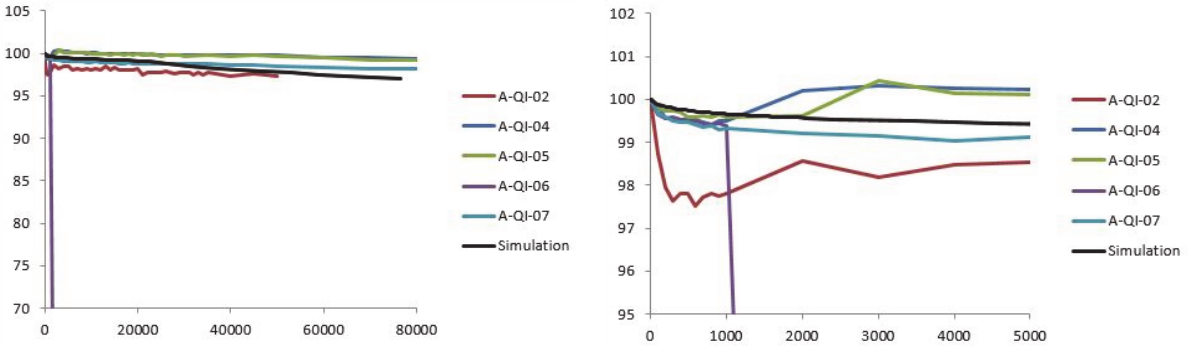
Figure 6: Predictability of stiffness reduction of a 3 point bending quasi-isotropic